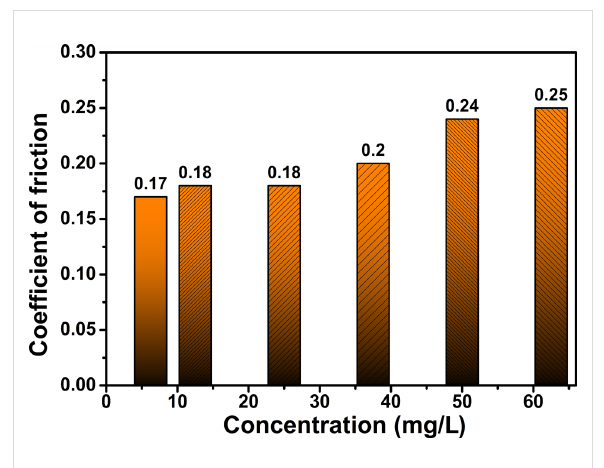
Figure 5: Coefficient of friction at high N-rGO concentrations.